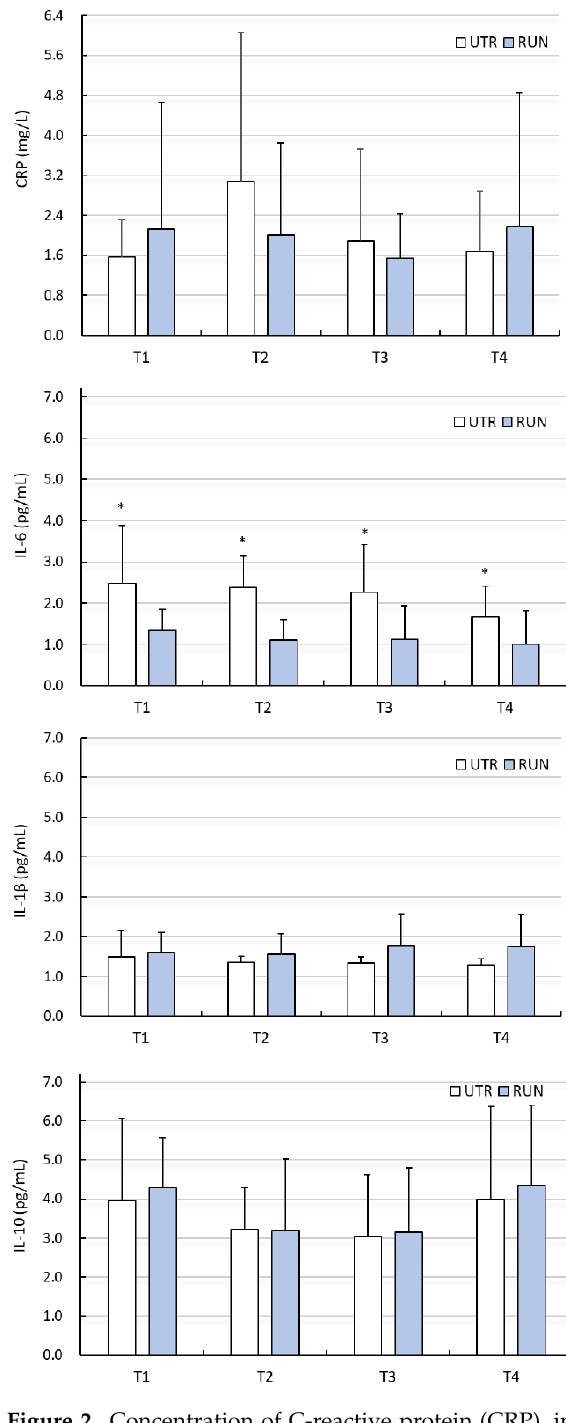
Figure 2. Concentration of C-reactive protein (CRP), interleukin 6 (IL-6), interleukin 1 β (IL-1 β ), interleukin 10 (IL-10) in blood plasma (mean ± standard deviation) in long-distance runners (RUN) and in untrained individuals (UTR) during the period of systemic cryotherapy (WBC) treatment and 7 days after its completion. *—statistically significant difference vs. RUN (p < 0.05); T1—measurement before 1 WBC, T2—measurement after 12 WBC, T3—measurement after 24 WBC, T4—measurement 7 days after completing WBC treatments.